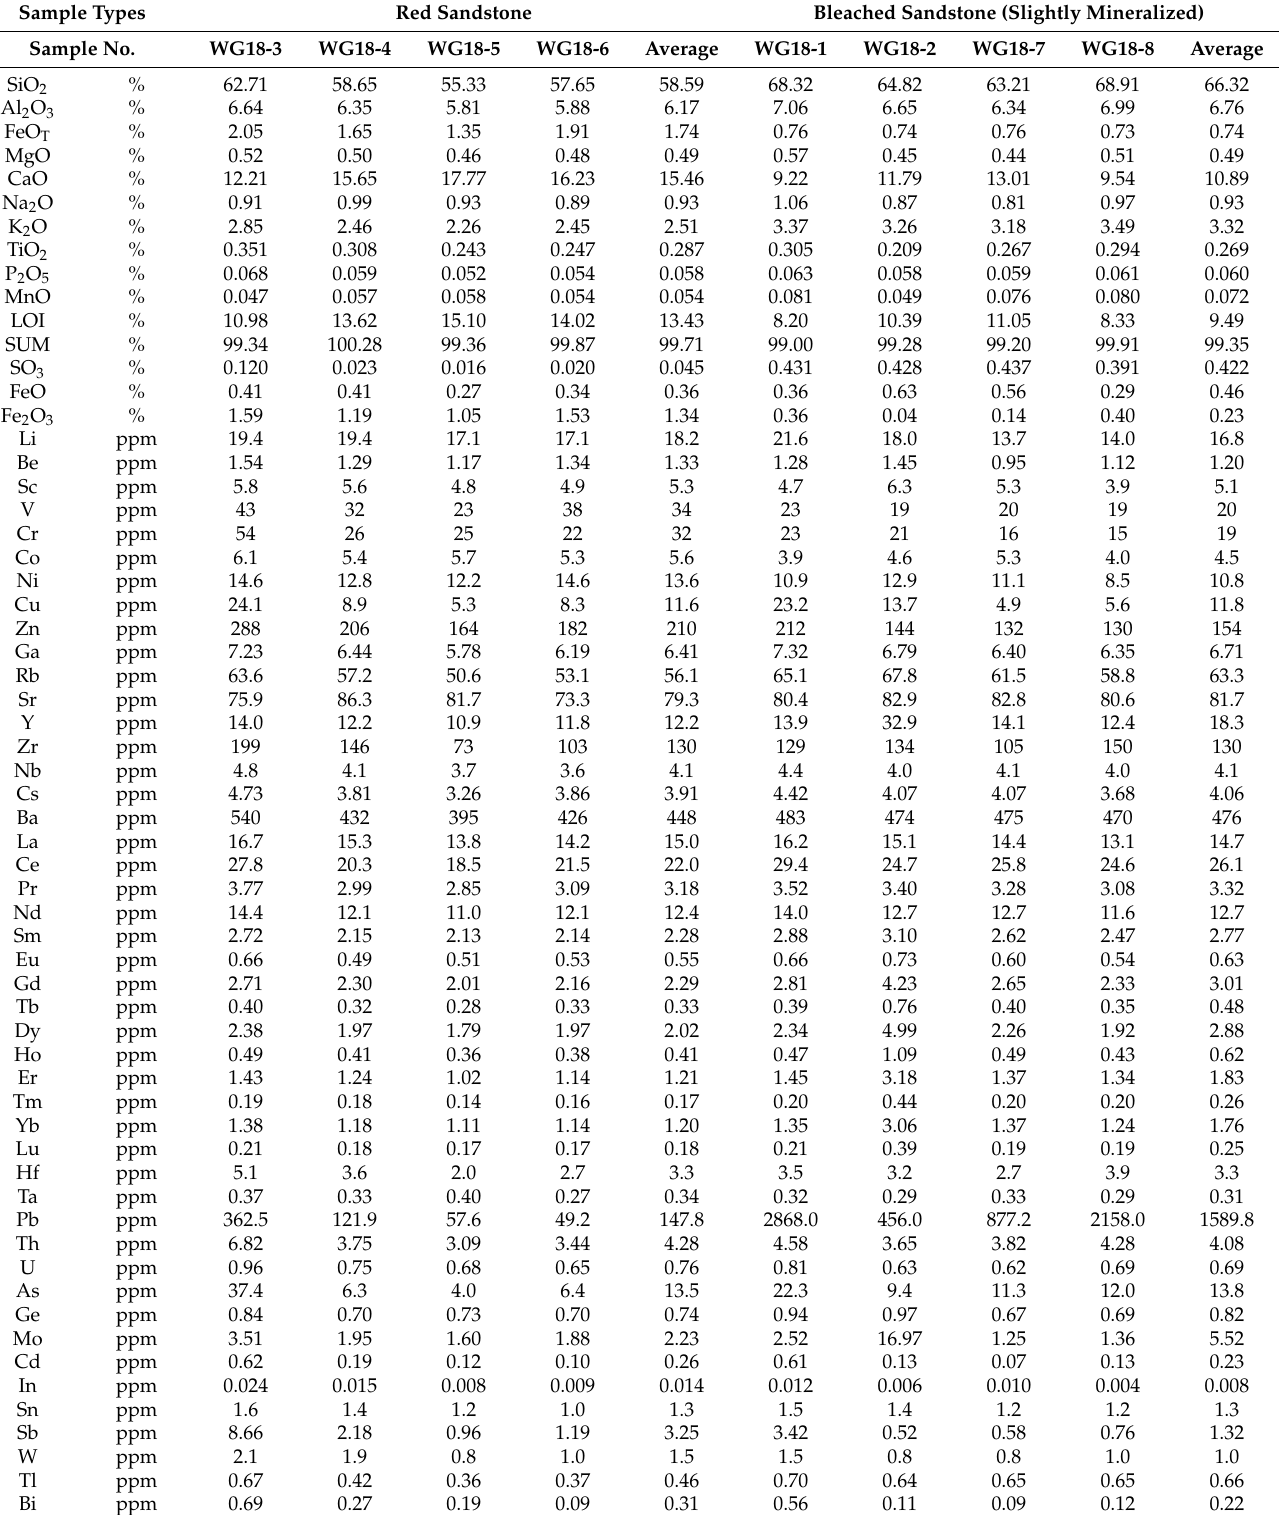
Table 1. Major and trace element contents of red and bleached sandstone at the same sedimentary layer in the Uragen Zn–Pb